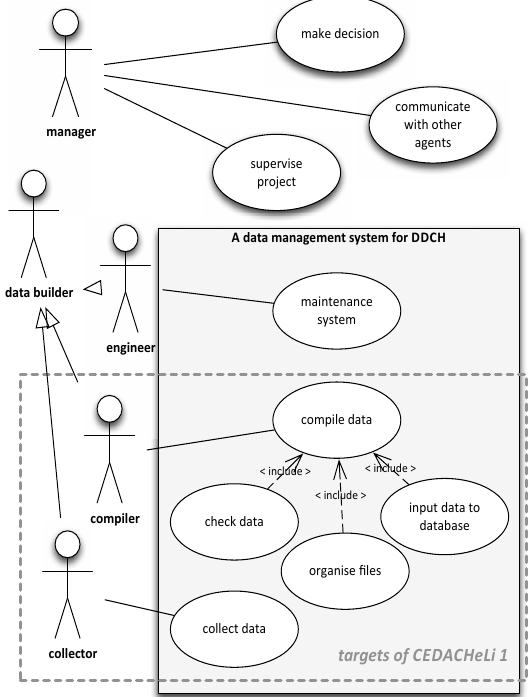
Figure 4: Flowchart illustrating how the CEDACHeLi is used 4